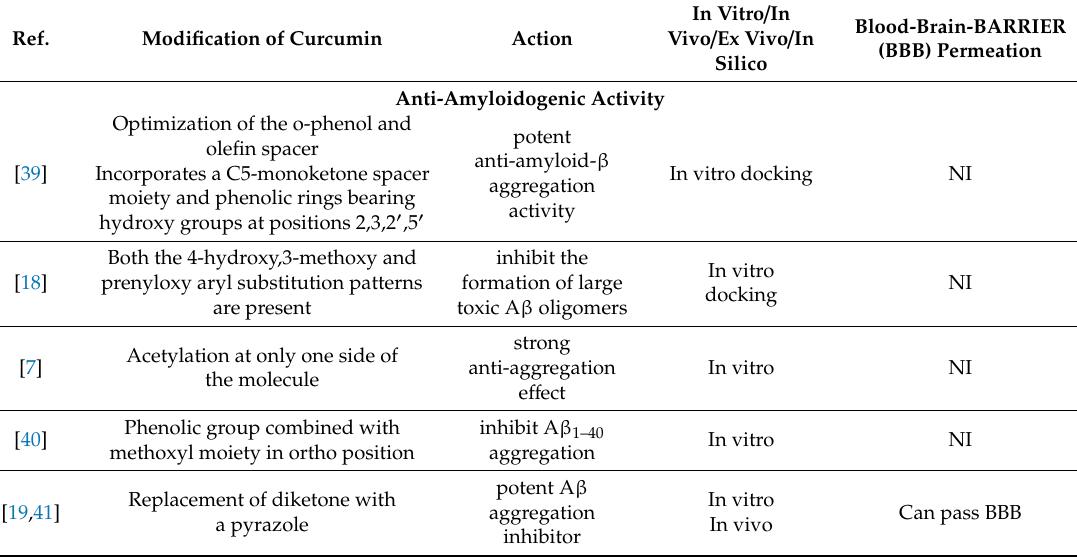
Table 1. Modifications of curcumin’s structure leads to anti-amyloidogenic activity.